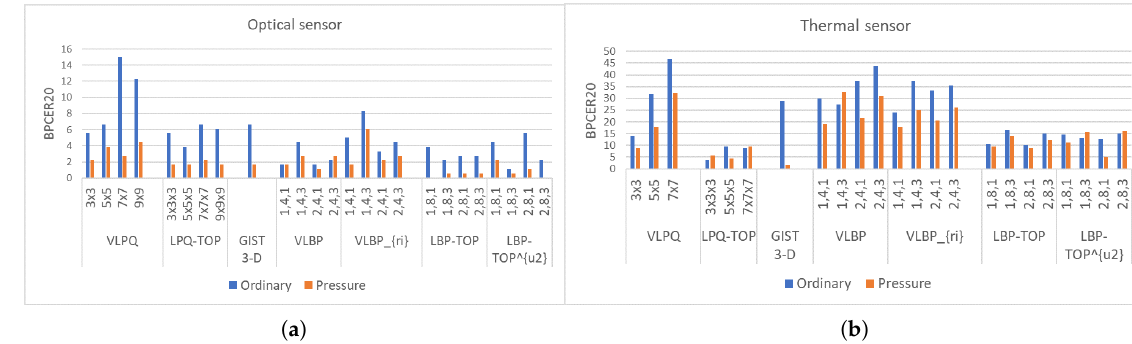
Figure 8. Scenario comparison for the proposed PAD subsystem considering the 5 feature extractors.